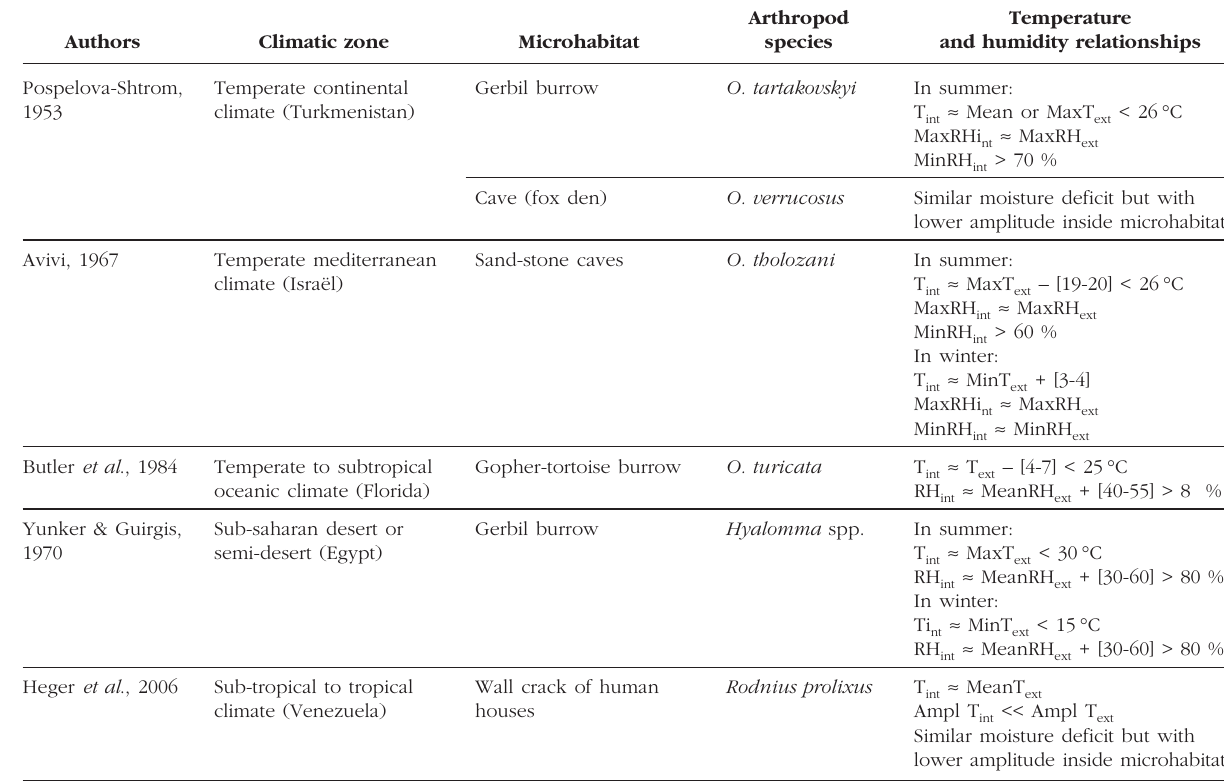
Table I. – Mathematical relationships (extracted from various studies) linking internal and external temperature and humidity of varied microhabitats inhabited by different endophilous tick species, or closely-related arthropods, in distinct climatic